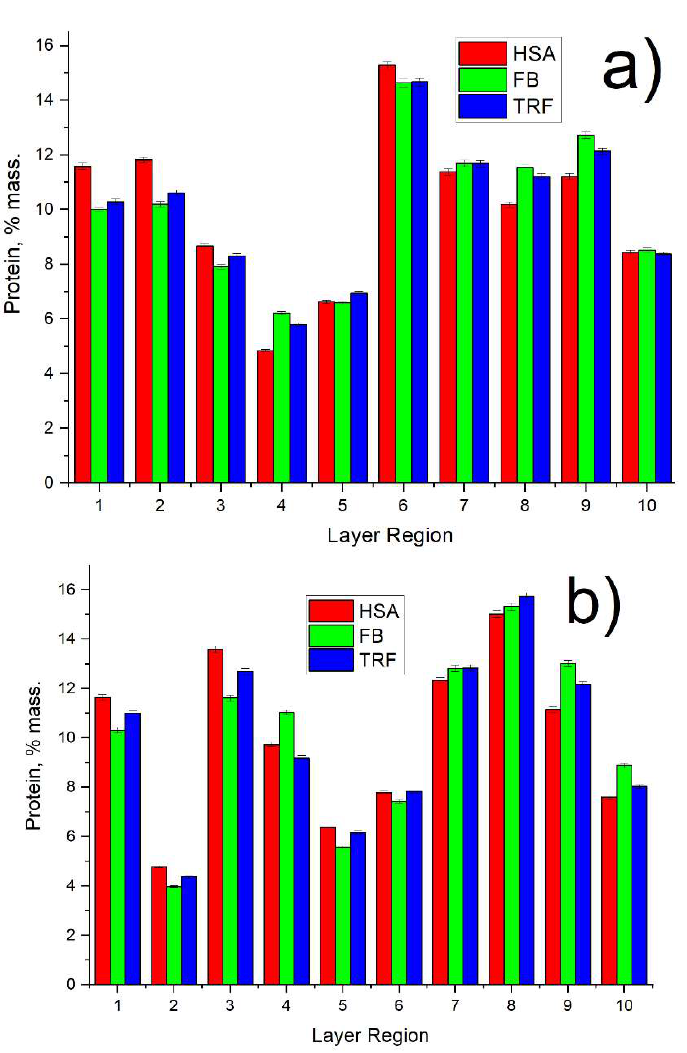
Figure 7. Protein distribution across membrane thickness for: ( a ) PVDF and ( b ) PVDF-ZW mem- branes.